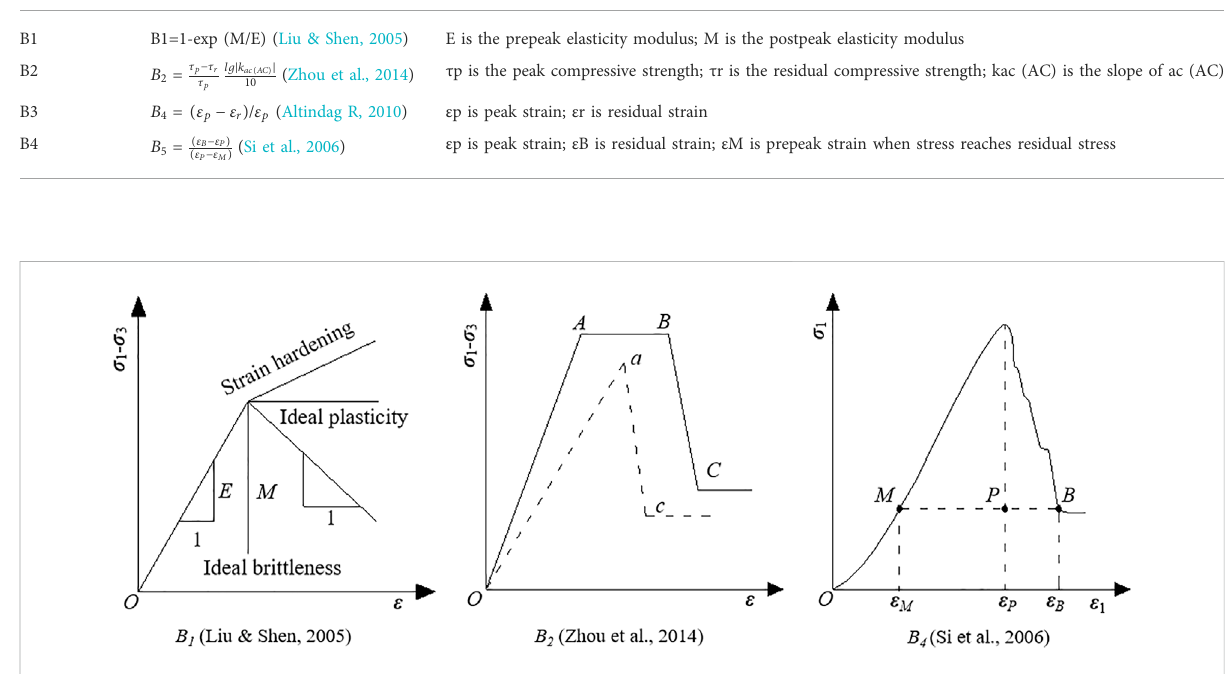
FIGURE 6 Schematic diagram of the calculation model of partial brittleness evaluation index.